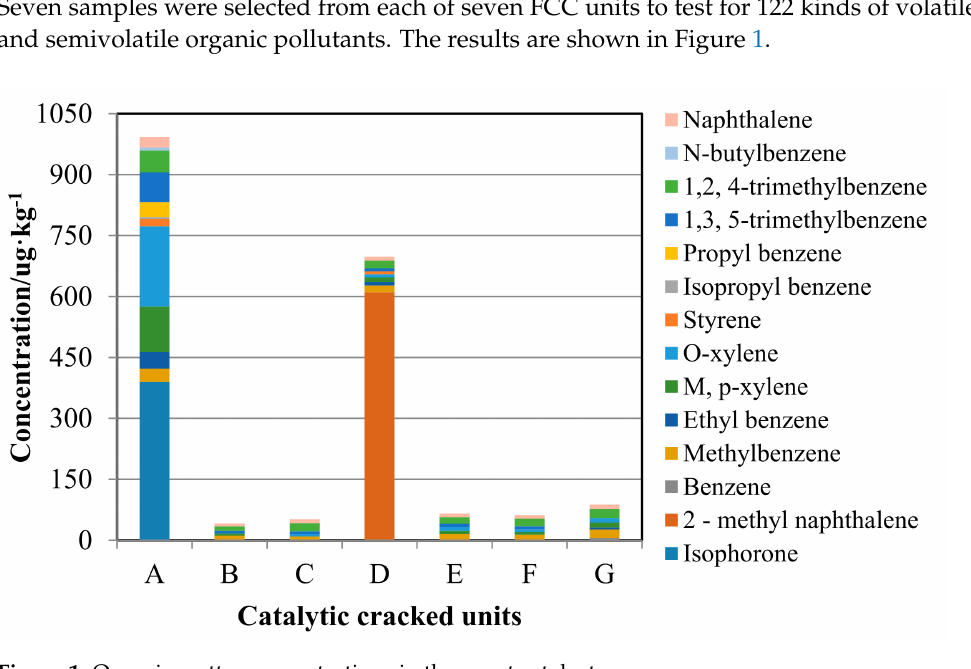
Figure 1. Organic matter concentrations in the spent